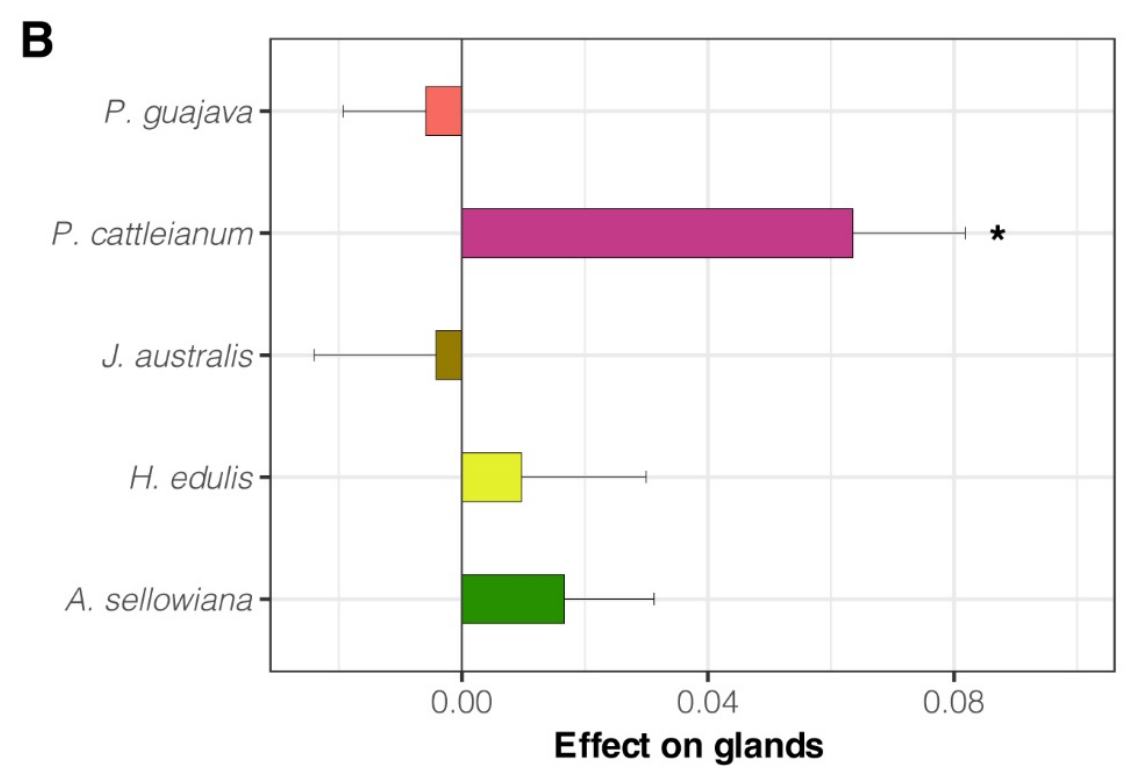
Figure 2. Effect of fruit volatile exposure on Anastrepha fraterculus sp. 1 male calling behavior, estimated through wing fanning ( A ) and salivary glands exposure ( B ). The figure shows the mean (±SE) effect on the male calling index (the difference between the calling index of exposed males and non-exposed males). Asterisks indicate significant differences between exposed and non-exposed males. Wing fanning: Psidium guajava p = 0.004, Psidium cattleianum p = 0.034; Salivary glands exposure: P. cattleianum p < 0.001.